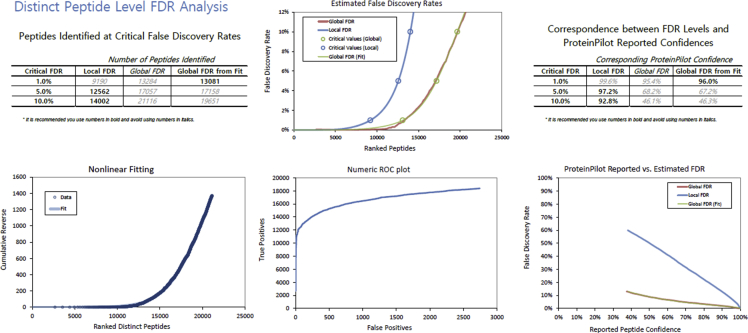
FDR analysis report of comprehensive IDA library from chicken corneas at peptide level generated by ProteinPilot software.